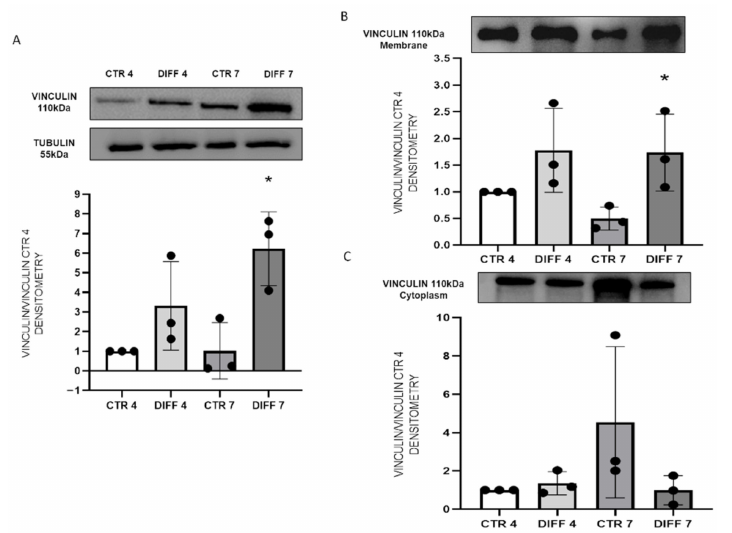
Figure 4. Western blot analyses with anti-vinculin and anti-tubulin antibodies on H9c2 after 4 and 7 days of differentiation. Proteins were revealed ( A ) on total proteins, ( B ) on membrane fraction, and ( C ) on cytoplasm fraction. All results were normalized with control at day 4. Densitometry results obtained from three different experiments are expressed as mean ± SD. Statistical significance with respect to relative controls (* p ≤ 0.05).